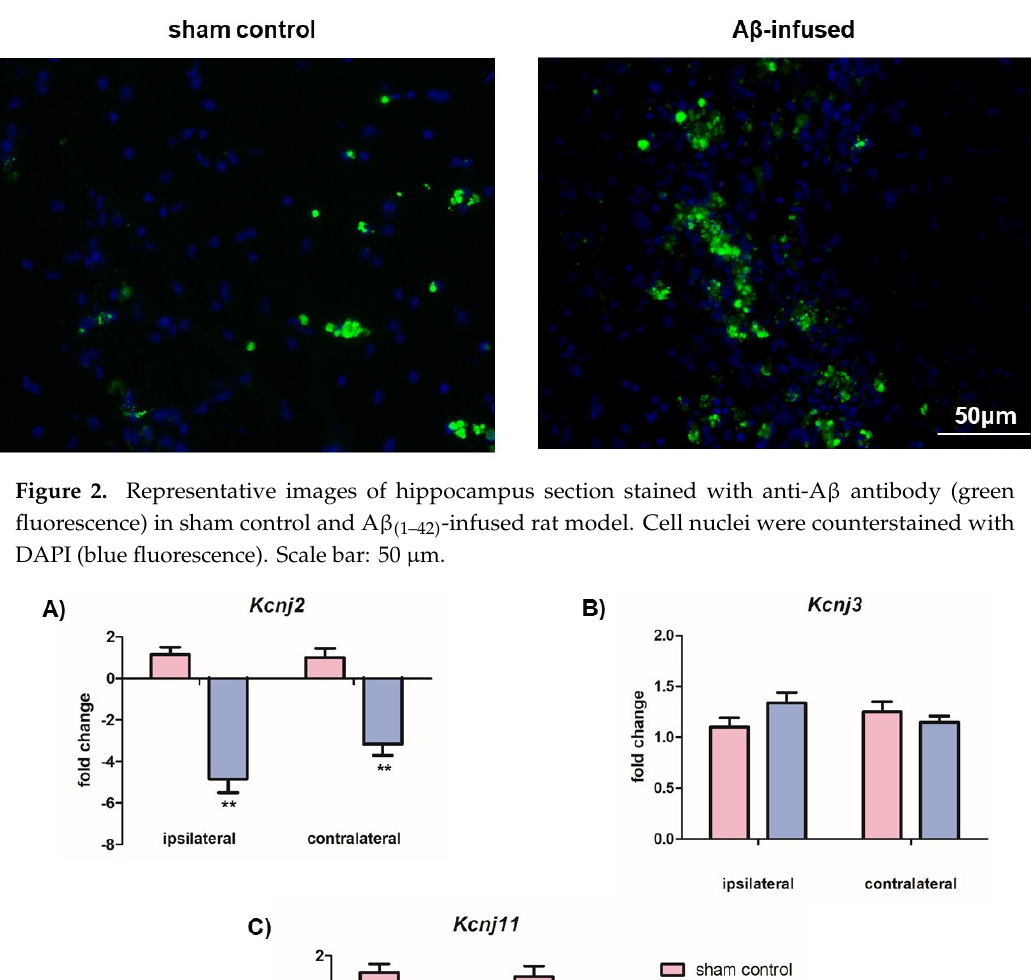
Figure 2. Representative images of hippocampus section stained with anti ‐ A β antibody (green fluorescence) in sham control and A β (1–42) ‐ infused rat model. Cell nuclei were counterstained with DAPI (blue fluorescence). Scale bar: 50 μ m.